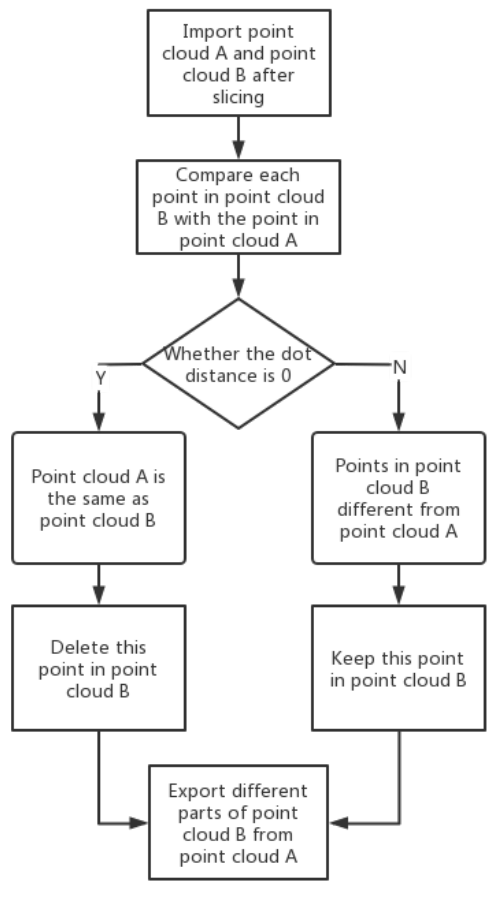
Figure 4 . Point Cloud Overlay Analysis Process